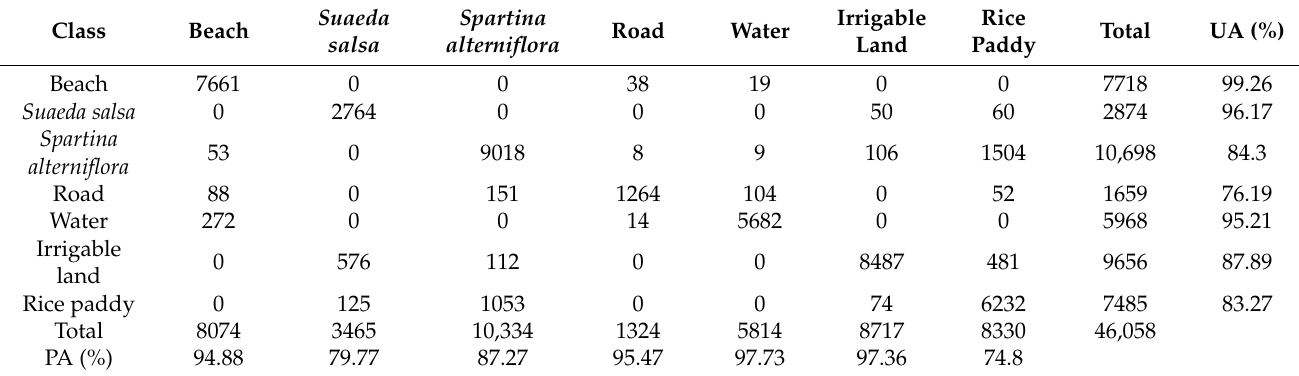
Table 8. Confusion matrix of the classification results from the ALL features set using random forest.